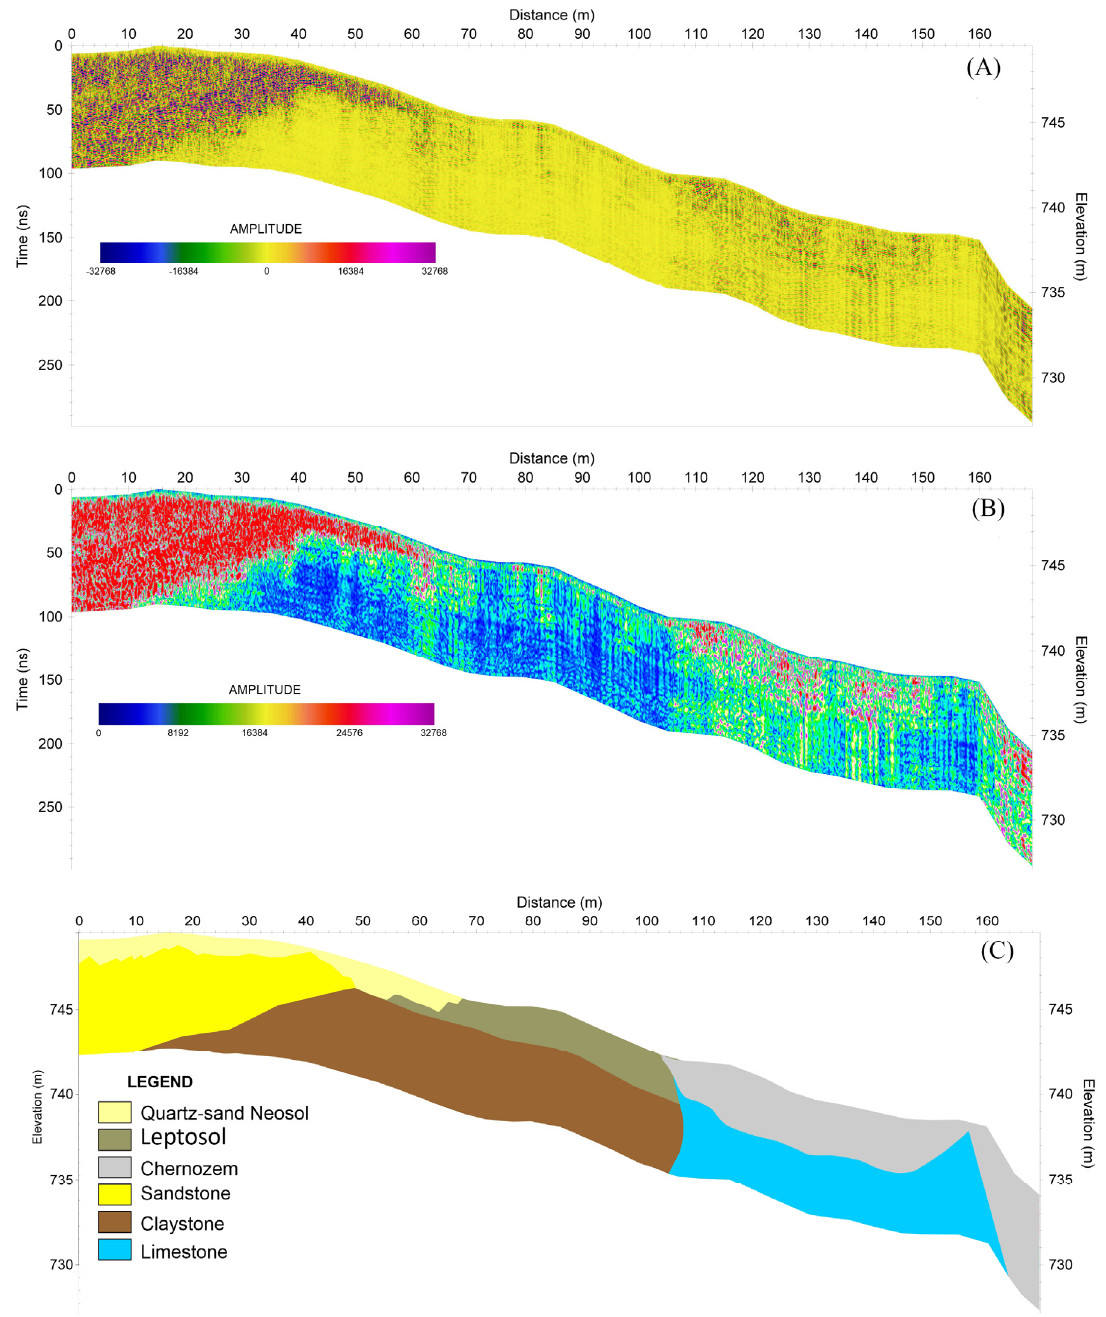
Figure 8. ( A ) GPR results, the color bar represents the values of georadar amplitude. ( B ) Instantaneous amplitude of georadar calculated after applying Hilbert transformation and ( C ) lithological cross-section obtained from GPR amplitude. Different soil types as well as a sharp contact between the carbonate of Bambui group and soil is evident. Prominent georadar typologies are focused on in Figure 9.